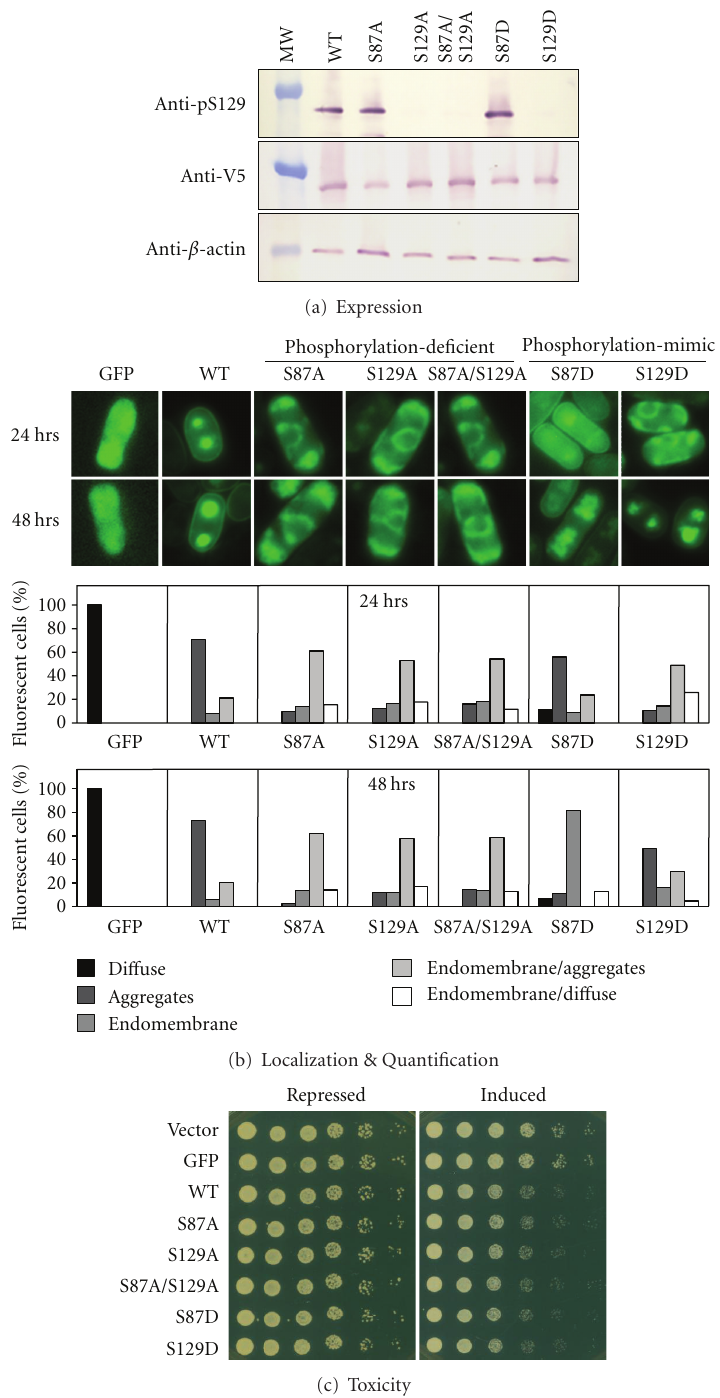
Figure 2: Characterization of phosphorylation mutants in TCP1. (a) Western blot of WT, phosphorylation-deficient mutants (S87A, S129A, and S87A/S129A), and phosphorylation-mimic mutants (S87D, S129D). TCP1 lysates were probed with anti-pS129 (top), anti- V5 ( α -synuclein; middle), and anti- β -actin (bottom) ( N = 3). (b) Live-cell GFP microscopy of TCP1 cells expressing GFP, WT, S87A, S129A, S87A/S129A, S87D, or S129D at 24 and 48 hours ( top ). Quantification: ∼ 750 cells of each type were scored for these localization patterns: cytoplasmically di ff use, aggregate, endomembrane, endomembrane/di ff use, and endomembrane/aggregate ( bottom ). Phenotypes were plotted as a percent of total cells that fluoresced ( N = 2). (c) Cells expressing WT, S87A, S129A, S87A/S129A, S87D, or S129D were grown in inducing (EMM − T) media for 48 hours. Vector alone and GFP served as controls. Equal number of cells were serially diluted 5-fold and spotted onto repressing (EMM+T) or inducing (EMM − T) plates and grown for two days ( bottom ). No phosphorylation-specific toxicity was apparent in either assay ( N =